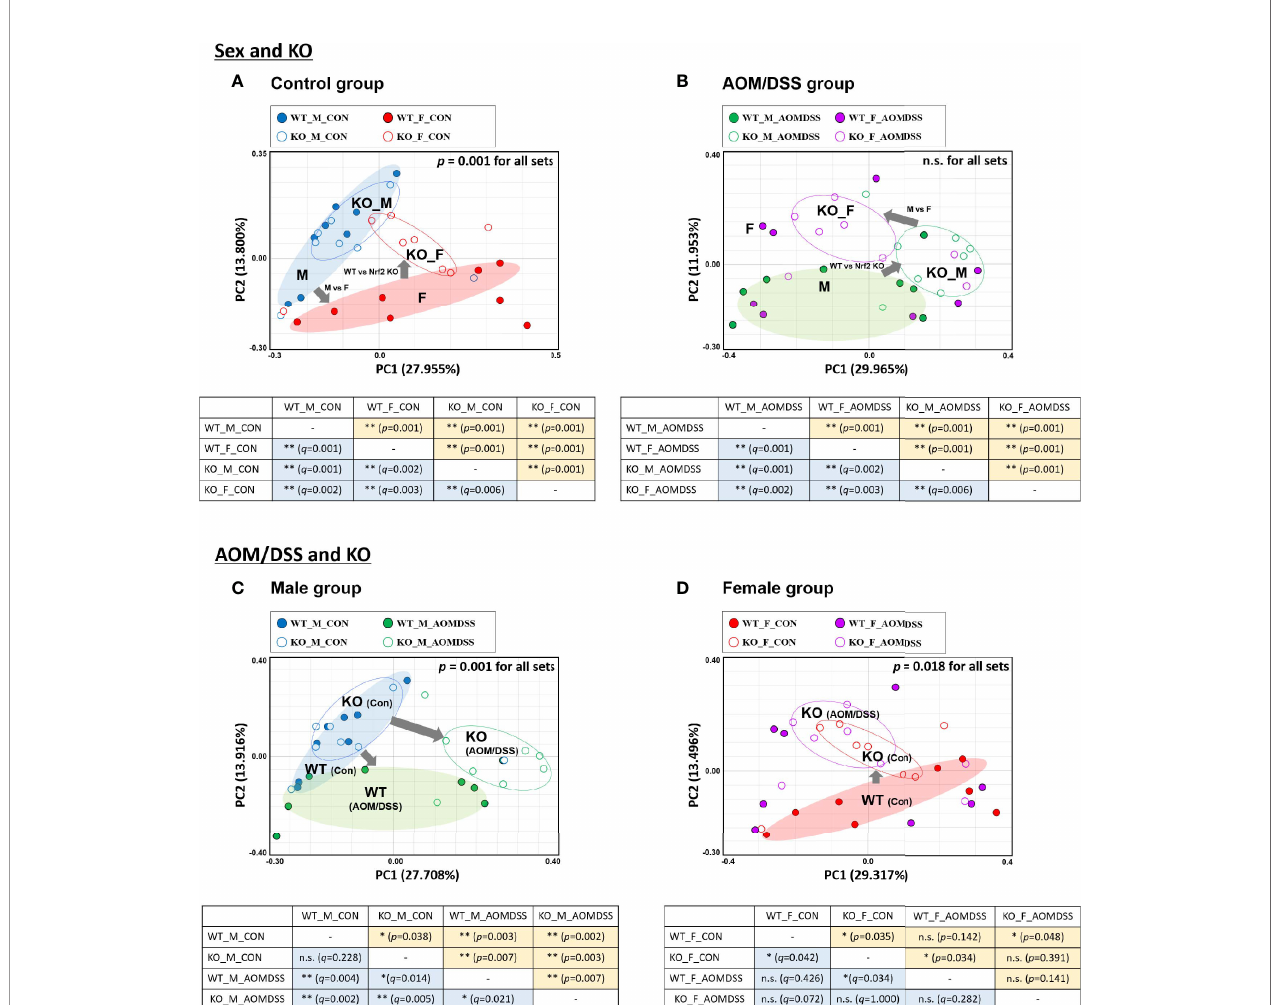
FIGURE 2 | UniFrac-based PCoA of 16S rRNA sequence from 64 fecal samples. Samples derived from control (A) and AOM/DSS-treated groups (B) with “ Sex and KO ” criteria, as well as those derived from male (C) and female mice (D) with “ AOM/DSS and KO ” criteria, were clustered using the Generalized UniFrac method at the species level. PERMANOVA was performed to examine the dissimilarity of bacterial population structures in (A – D) . Below each PCoA plot, the PERMANOVA statistics between the two groups are shown. Signi fi cance for p - and q -values is indicated by asterisks: *, < 0.05; **, < 0.01; n.s. not signi fi cance. The clustering of each group is marked with a different color: WT_M_CON, fi lled blue ellipse; WT_F_CON, fi lled red ellipse; WT_M_AOM/DSS, fi lled green ellipse; KO_M_CON, blanked blue ellipse; KO_F_CON, blanked red ellipse; KO_M_AOM/DSS, blanked green ellipse; KO_F_AOM/DSS, blanked purple ellipse. PCoA, principal coordinate analysis; WT, wild-type; KO, Nrf2 knockout; AOM, azoxymethane; DSS, dextran sodium sulfate; M, male; F, female; PERMANOVA, permutational multivariate analysis of